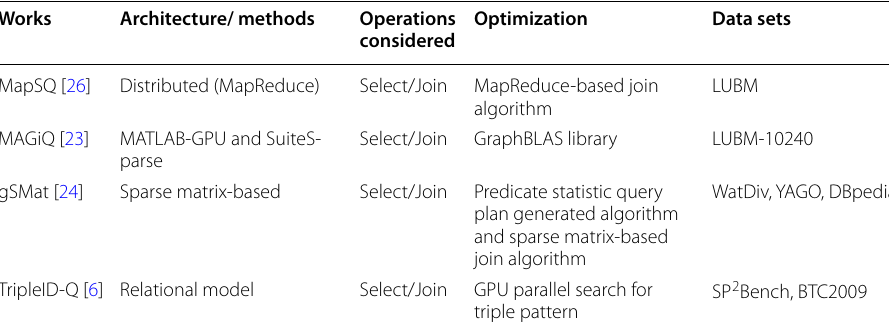
Table 2 Comparison of query processing for GPU-based approaches Works Architecture/ methods